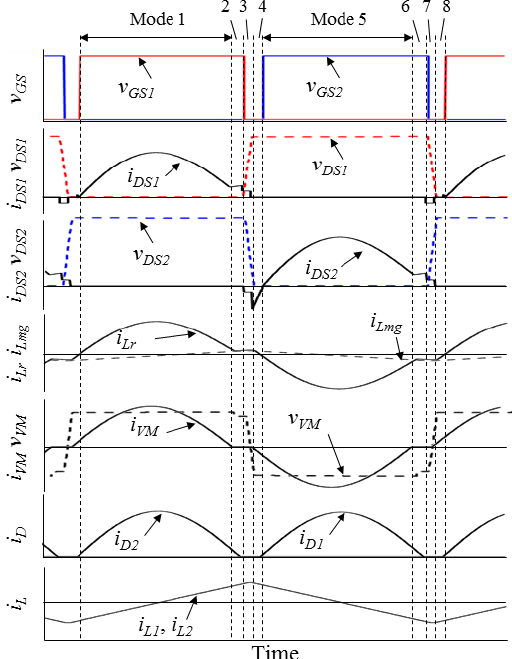
Figure 8. Theoretical key operation waveforms when PV 1 is shaded.